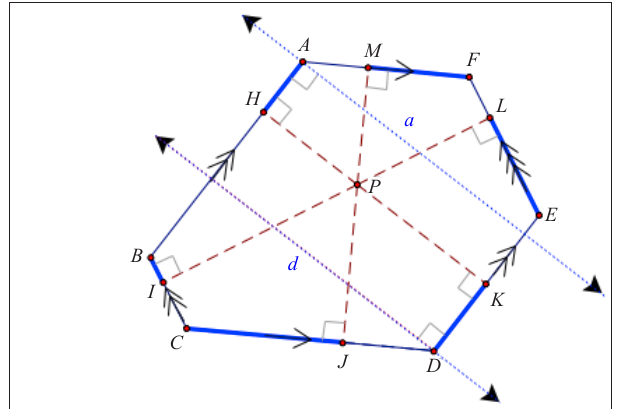
FIGURE 6: A hexagon with opposite sides parallel.